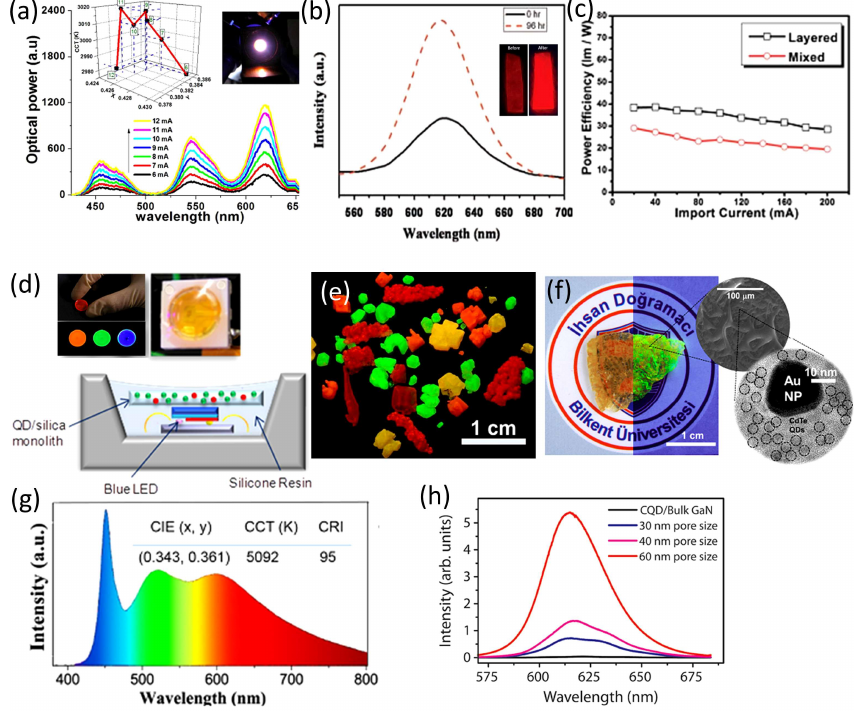
Figure 1: (a) Spectrum of the quantum dot (QD)-integrated white light-emitting diode (LED) exhibiting a color rendering index (CRI) ~90, luminous eflciency of the optical radiation (LER) = 357 lm/W opt , and correlated color temperature (CCT) = 2982 K. Reproduced with permis- sion from Ref. [10], Copyright Optical Society of America. (b) Photoluminescence of the red-emitting QDs embedded within silicone before (black curve) and after (red curve) ultraviolet (UV) treatment along with the real-color photographs of their films under UV illumination be- fore and after the UV treatment (inset). Reproduced with permission from Ref. [19], Copyright Wiley International. (c) Luminous